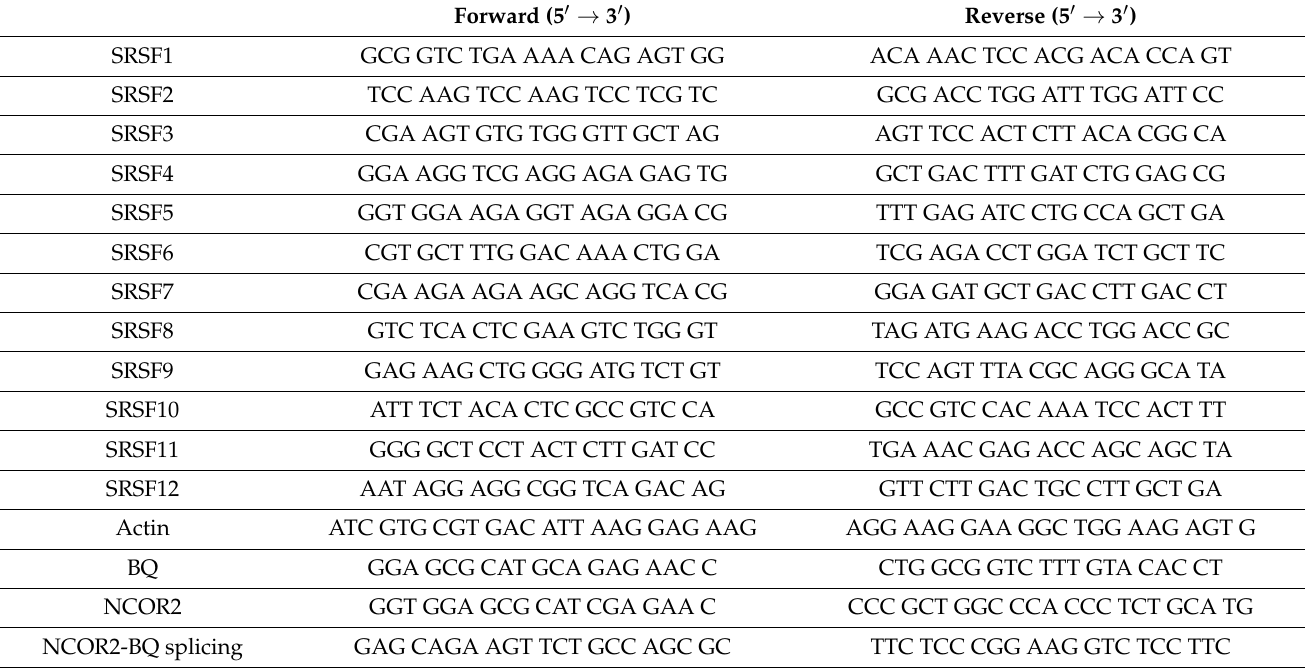
Table 1. DNA sequences of